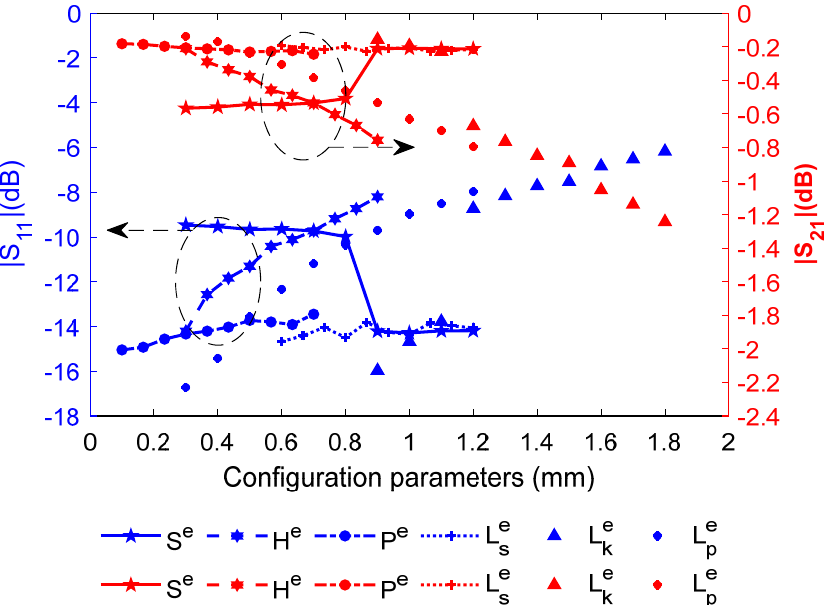
Figure 12. Comparison of single parameter simulation for interconnected configurations.